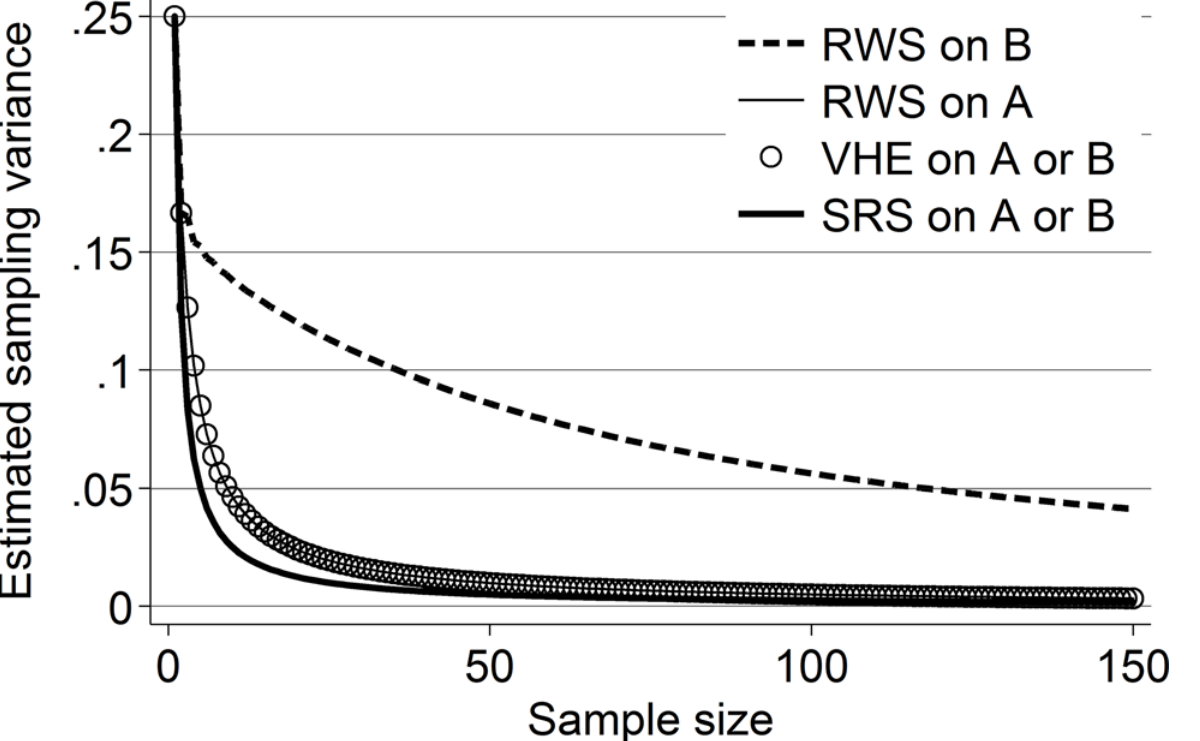
Fig 2. Sampling variances on Networks A and B from Fig 1, by method and sample size. Note: Like SRS, VHE produces identical estimates on networks A and B. For both networks, these estimates are identical to the population RWS sampling variance on A because network A is